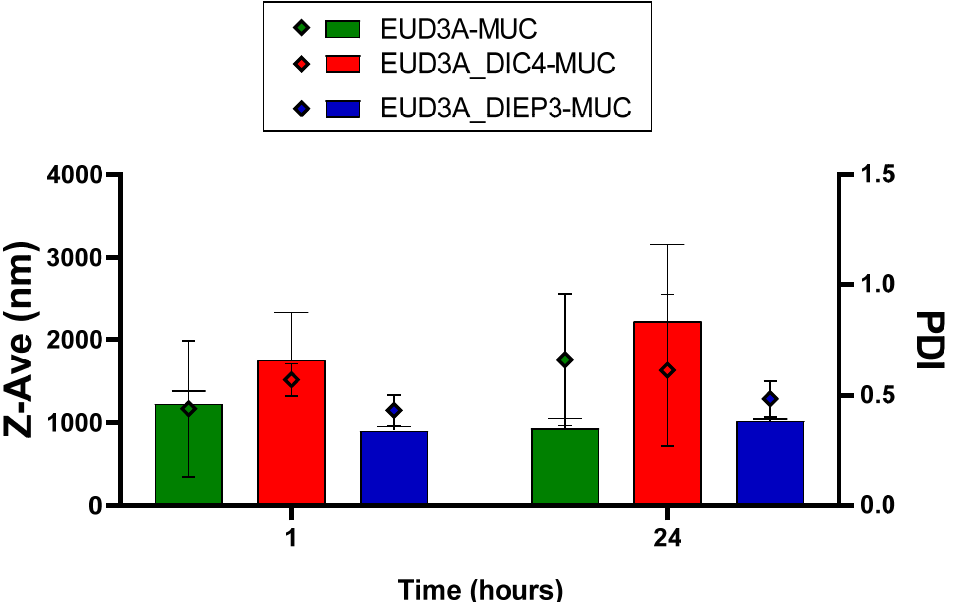
Figure 3. EUD3A, EUD3A_DIC4, and EUD3A_DIEP3 mean size (Z-Ave, bars) and PdI (symbols) after 1 and 24 h of incubation with mucin at 37 °C (EUD3A-MUC, EUD3A_DIC4-MUC, and EUD3A_DIEP3-MUC).